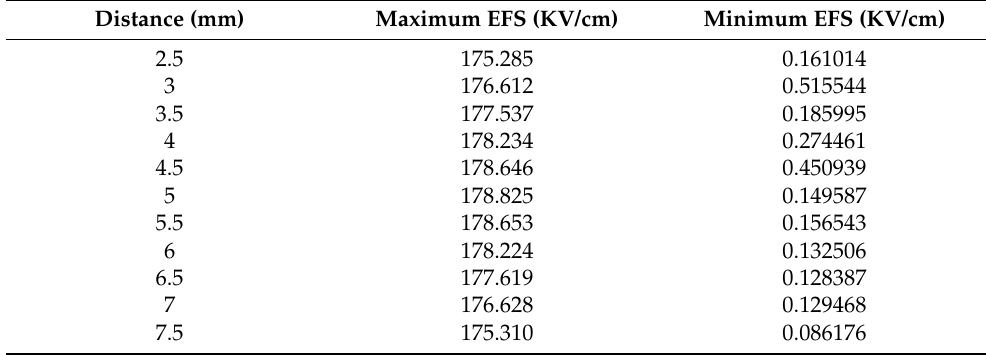
Table 2. Variation of EFS of rocks with distances between bubbles with the electric potential.